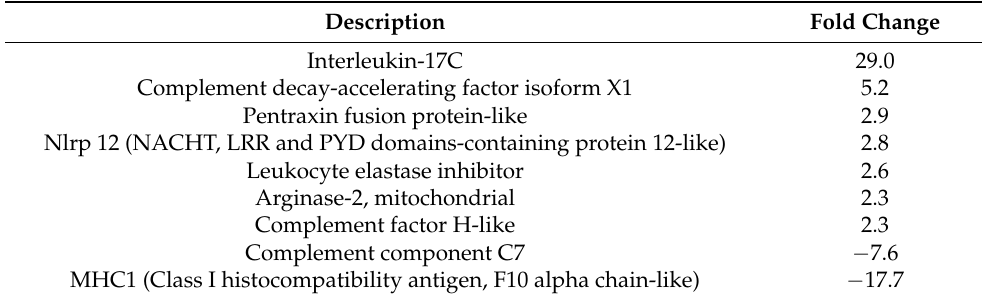
Table 3. Genes associated with the immune response that are differentially expressed in non-viable larvae in comparison with viable larvae in European eel Anguilla anguilla . Both groups represent larvae samples taken 1 dph after which non-viable larvae survived less than 3 dph while viable larvae survived for at least a week up to 22 dph.